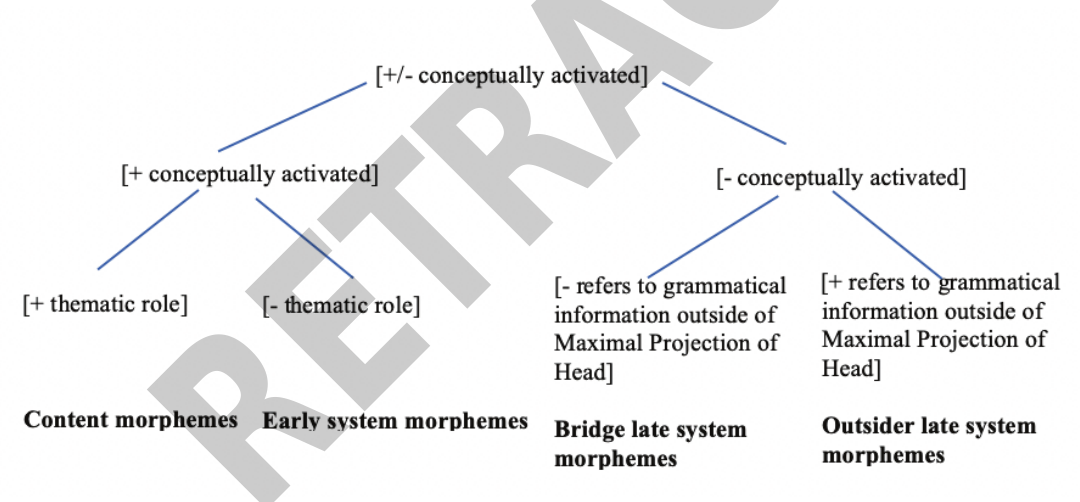
Figure 1: Feature-based classification of morphemes in the 4-M